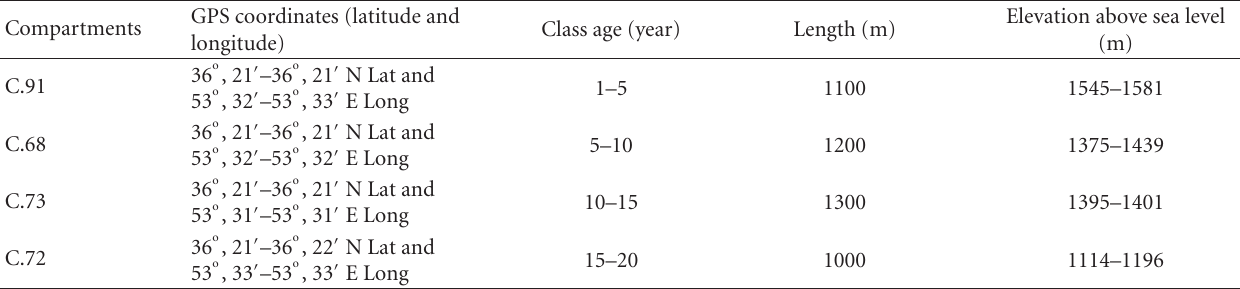
Table 1: Summary of the skid trail information.